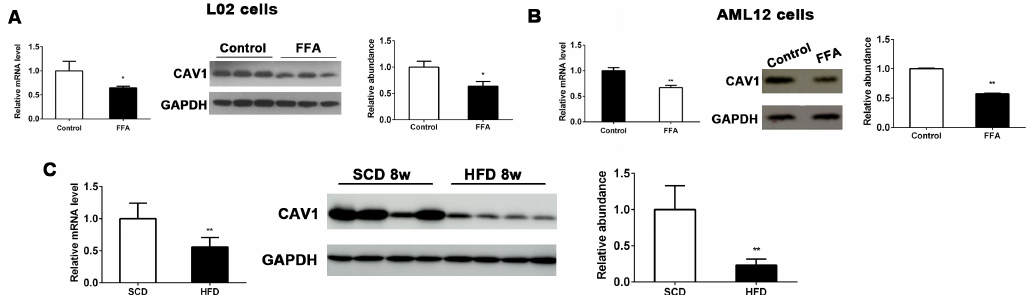
Fig 1. CAV1 expression is downregulated in FFA-treated hepatocytes and in the livers of HFD-fed mice. CAV1 mRNA and protein expressionlevels were analyzedby qPCR and western blot in L02 cells (A) and AML12 cells (B) treated with or without FFA for 48 h. The results were normalizedto the expressionlevel of GAPDH. The results are expressedas the mean ± SD of 3 independent experiments. * P < 0.05 and ** P < 0.01 comparedwith cells cultured without FFA. (C) HepaticmRNA and protein expressionlevels of CAV1 were markedly reducedin mice fed an HFD for 8 weeks. The results are expressedas the mean ± SD of 5 mice per group. * P < 0.05 and ** P < 0.01 comparedwith mice fed an